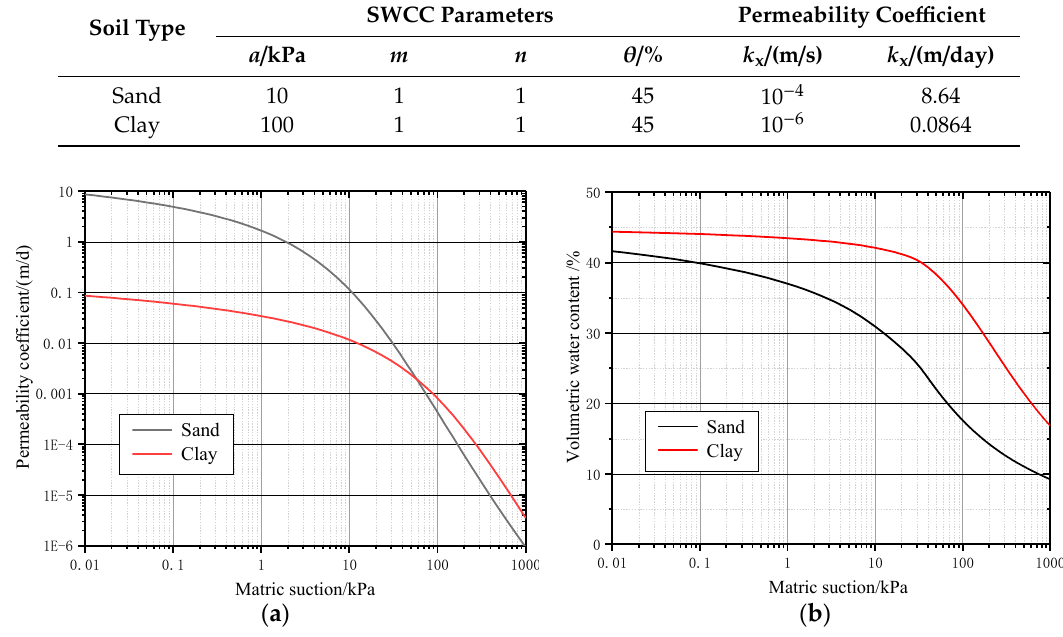
Figure 3. SWCC curves. ( a ) Permeability coefficient function. ( b ) Volume water content function.